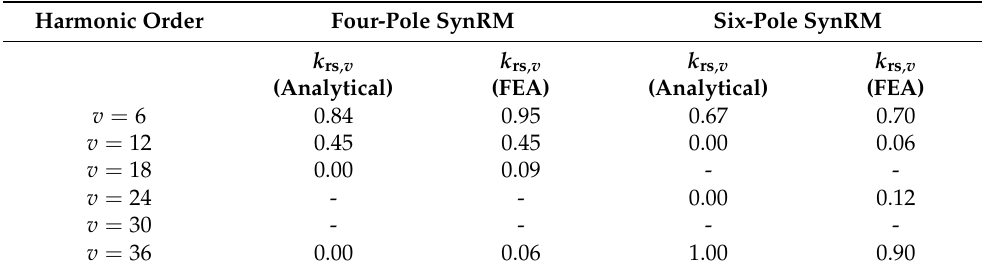
Table 5. Torque ripple harmonic component reduction as a result of three-step skewing. The 3D results are considered and the relevant harmonic components analyzed. Harmonic